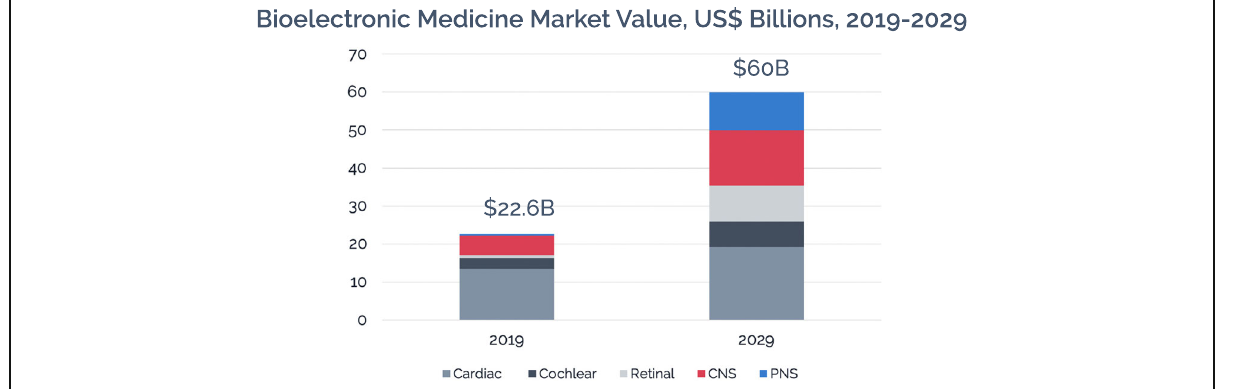
Fig. 1 Bioelectronic Medicine Market